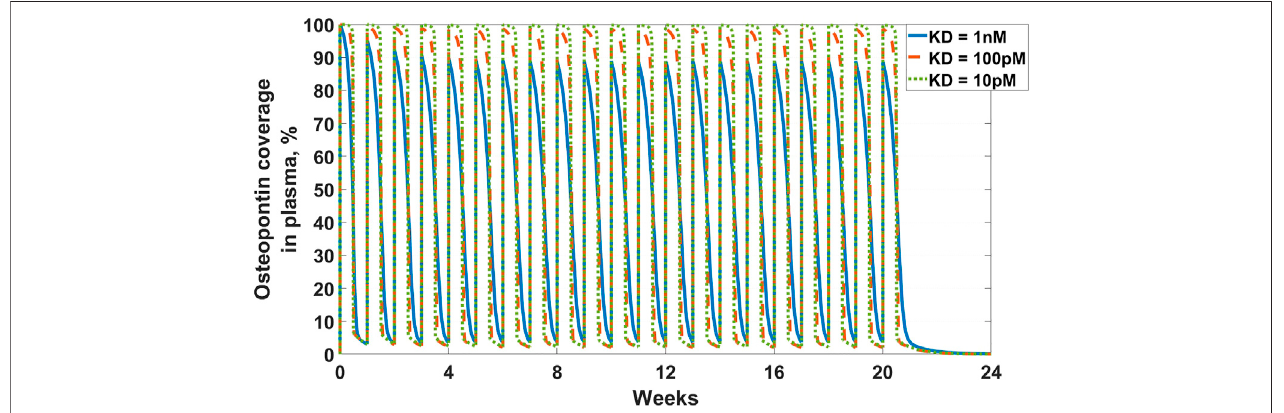
FIGURE 3 | Osteopontin coverage in plasma: Shows the projected neutralization of osteopontin after mAb administration as described in Osteopontin Example . Simulateddoseis1,000 mgIVQ1W,withthreeantibodyaf fi nities – K D of1 nM(solidblueline),100 pM(dashedorangeline),and10 pM(dottedgreenline).Allscenarios result in high peak neutralization, which is not sustained for the full duration of the dosing